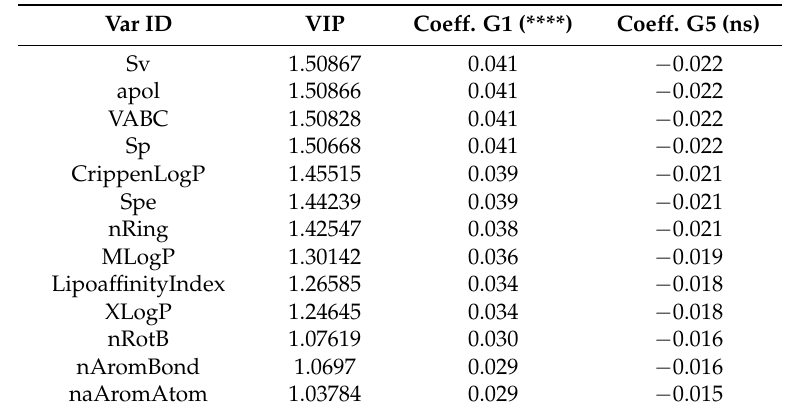
Table 4. VIP values higher than 1 of the O2PLS model for the PaDEL descriptors. The list is based only on VIPs >